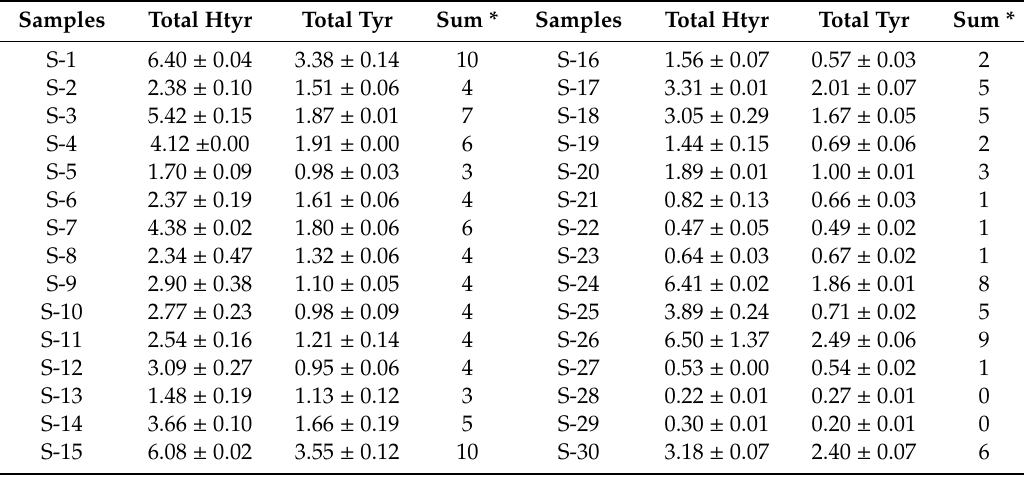
Table 5. Total (free and bound forms) Htyr and Tyr content (mg / 20 g oil) of VOO samples according to protocol